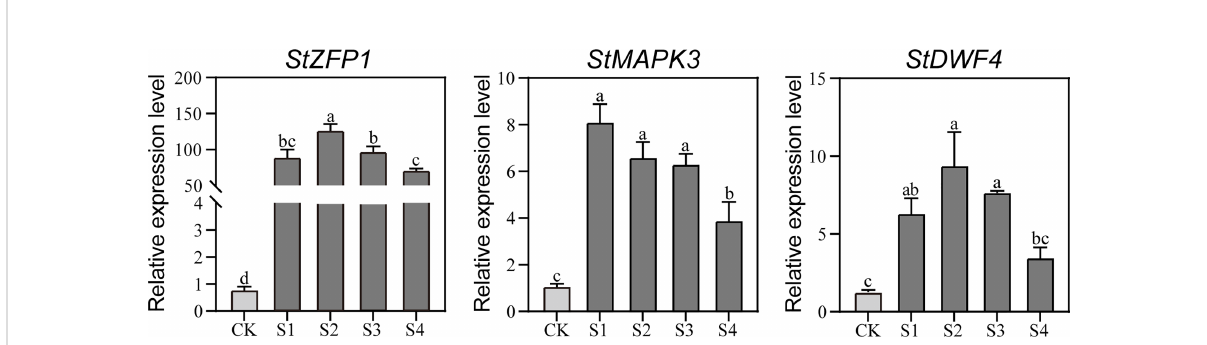
FIGURE 1 The qRT-PCR-based transcription analysis of the three NaCl-responsive genes in the DM plantlets under NaCl stress. Gene expression is normalized relative to the potato reference gene StActin97 . Data presented as mean ± standard error from three biological replicates were tested by one-way analysis of variance (ANOVA). Different letters represent statistically signi fi cant differences ( a =0.05). S1, S2, S3, and S4, represent the aboveground parts of DM text-tube plantlets under 200-mM NaCl treatment for 3, 6, 12, and 24 h, respectively; CK represents the aboveground parts of DM text-tube plantlets after 24 h treatment with MS liquid medium (the same